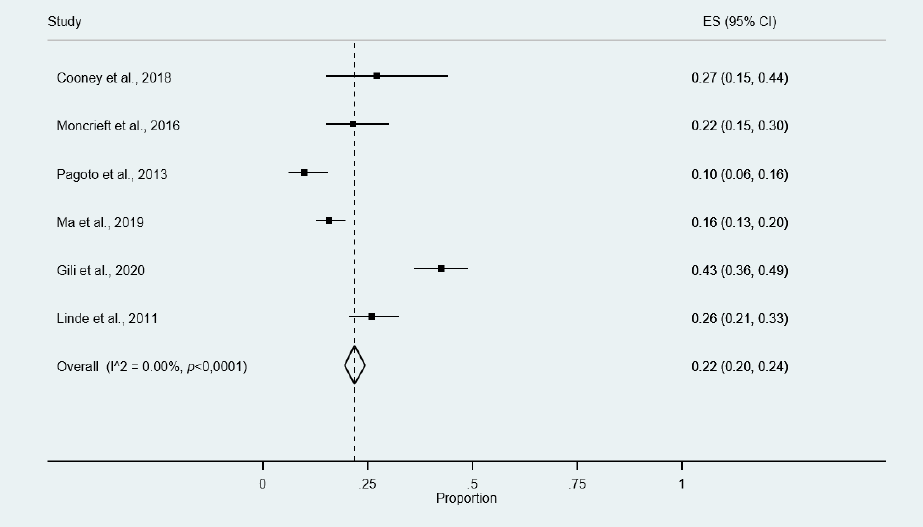
Figure 4. Meta-analysis of